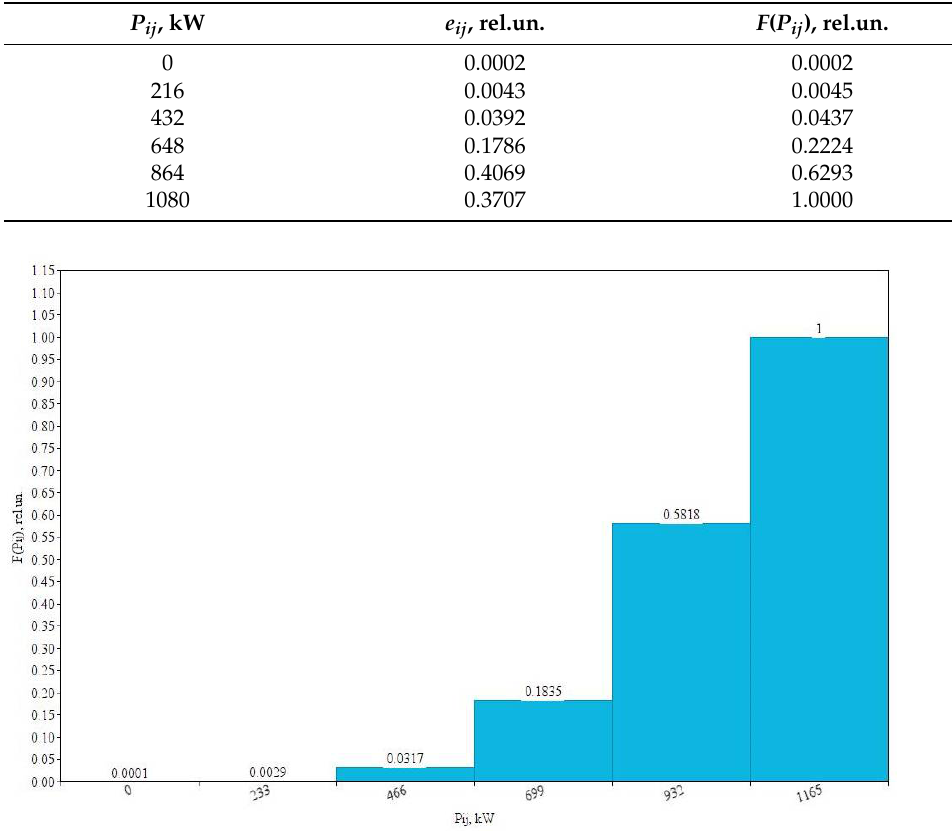
Figure 10. Step function of the probability distribution of the ordinates of the initial group ELC with the use of frequency control.